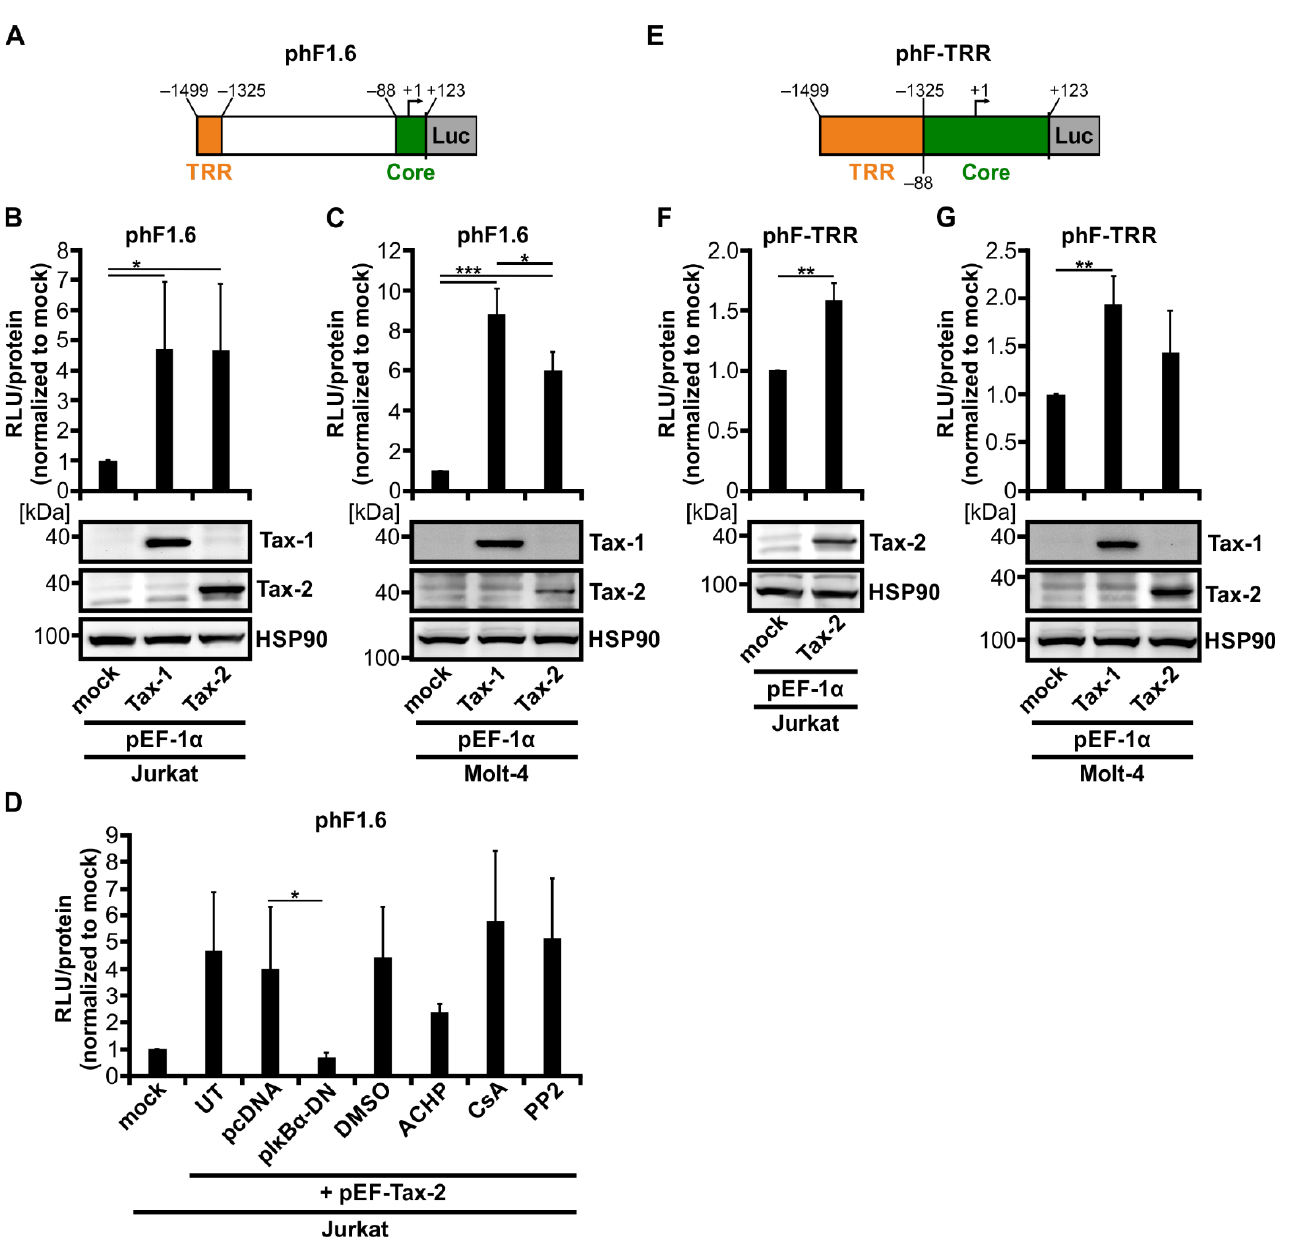
Fascin transcription compared to Tax-2, both the 1.6 kb fragment phF1.6 and the TRR seem to be necessary, but not sufficient to regulate oncoprotein-mediated Fascin expression.